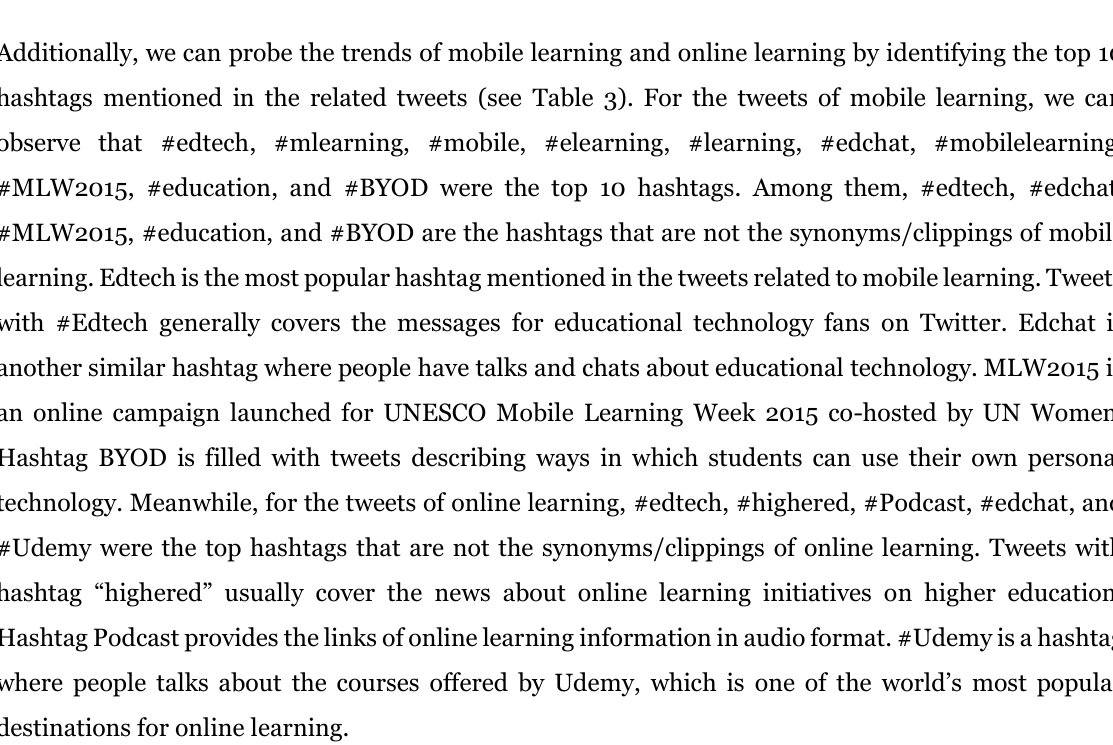
Figure 2. The volume trends of the most retweeted